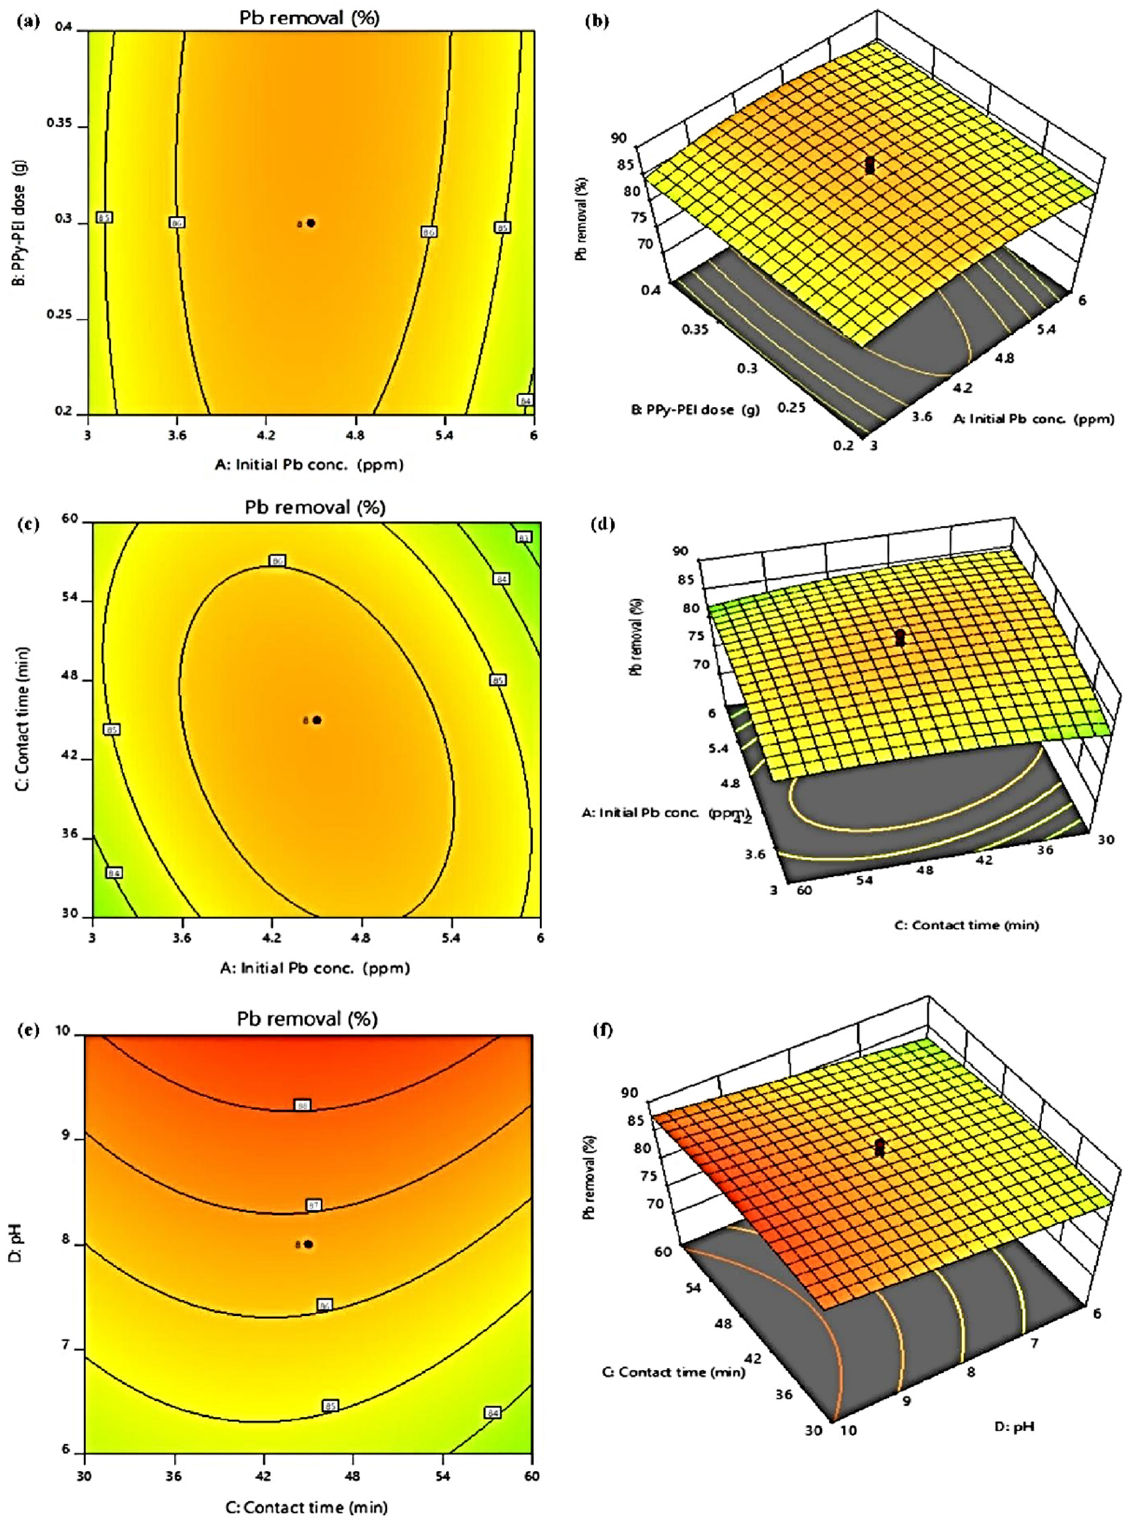
Figure 8. Contour plots and 3D response surface plots of Pb removal showing the interactive effects of ( a , b ) Initial Pb conc. and PPy-PEI dose, ( c , d ) Initial Pb conc. and contact time, ( e , f ) pH and contact time.